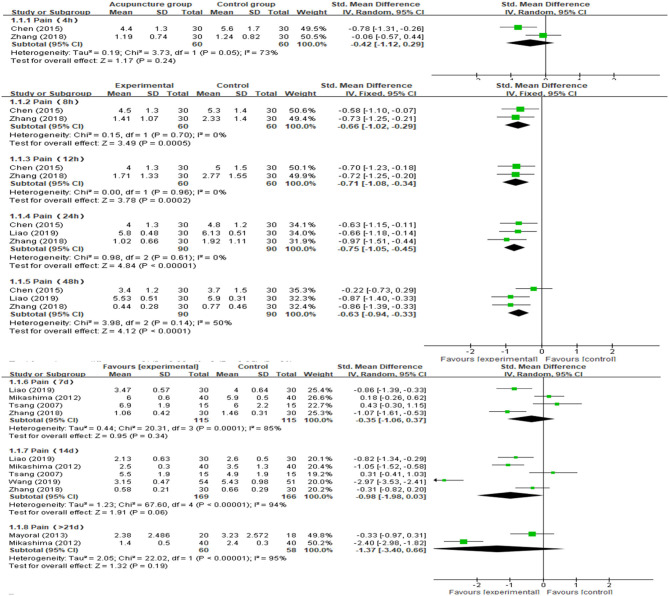
Meta-analysis and forest plot and for postoperative pain at different periods.